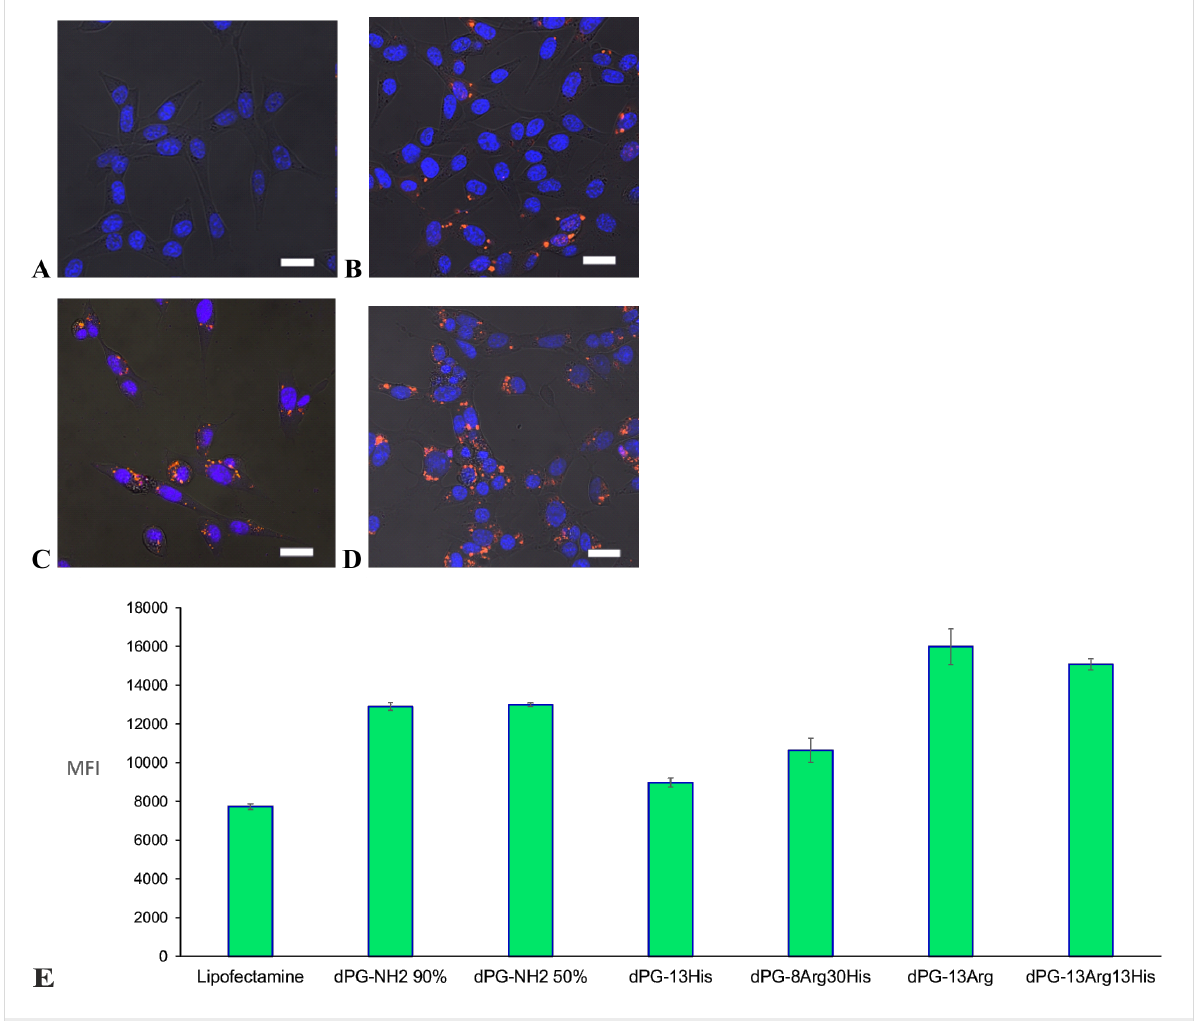
Figure 6: Confocal images of NIH 3T3 cells treated with Cy3-siRNA/vector complexes: (A) naked siRNA, (B) lipofectamine, (C) dPG-13His, (D) dPG- 13Arg, and (E) mean Cy-3 fluorescence intensity of 3T3 cells treated with Cy3-siRNA/vector complexes assessed by FACS.